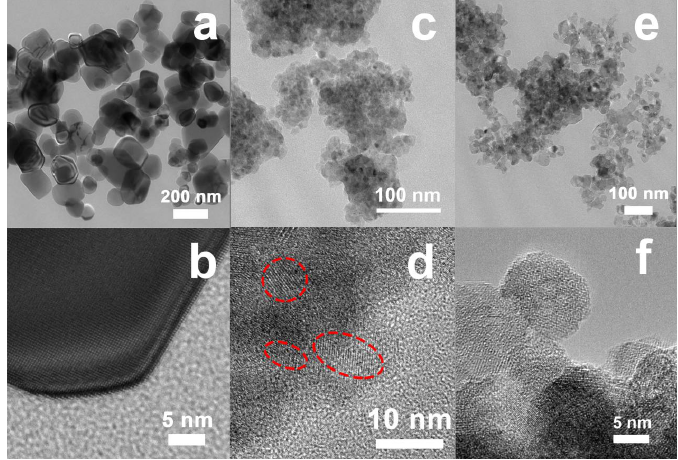
Figure 2. Transmission electron microscope (TEM) ( a , c , e ) and high-resolution transmission electron microscope (HRTEM) ( b , d , f ) images of the powders of the raw anatase TiO 2 ( a , b ) and the samples 2Si ( c , d ) and 2Si-N ( e , f ) milled at the speed of 800 rpm.